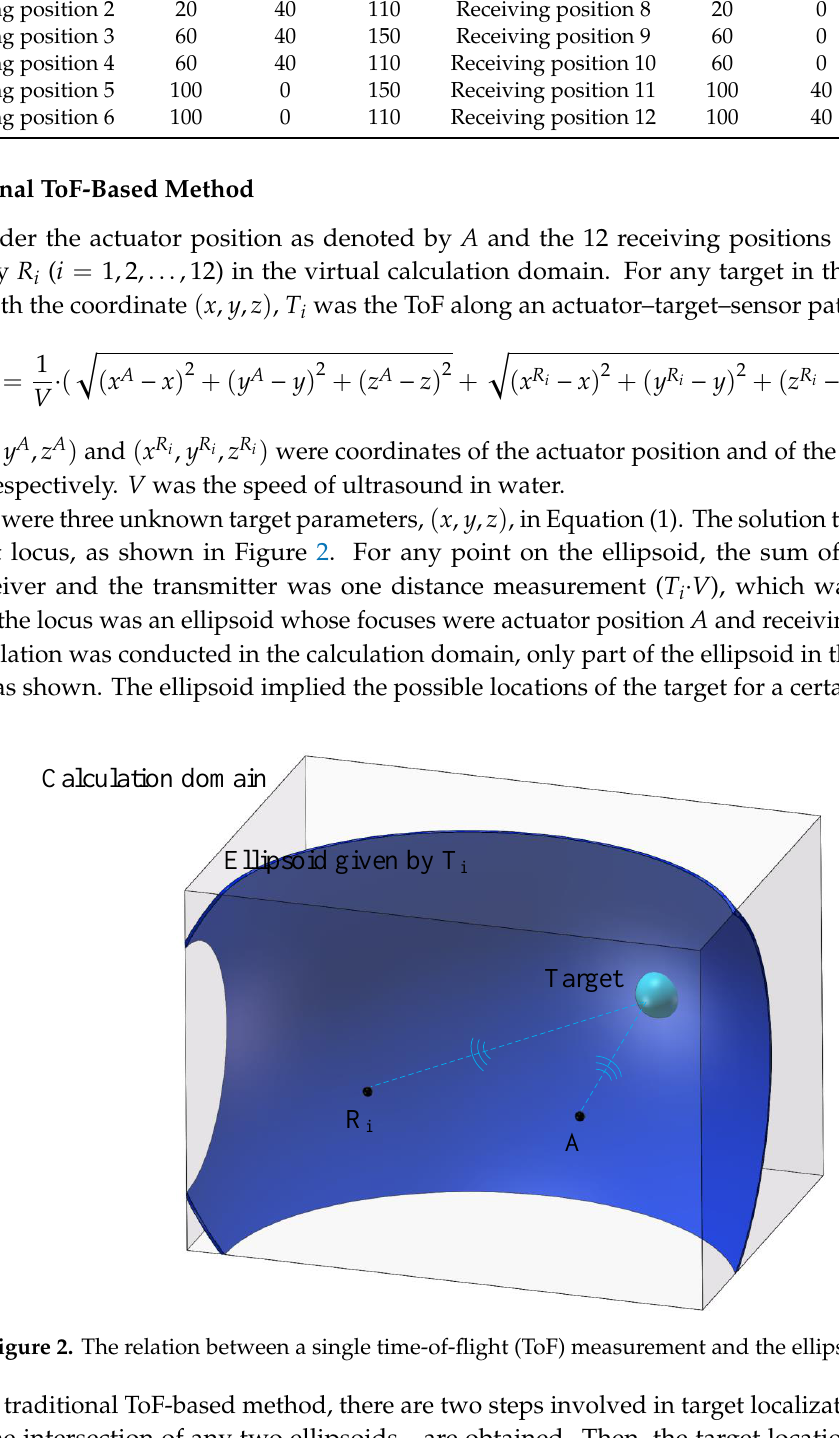
Table 1. The coordinates of the actuator, the 12 receiving positions, and the target.